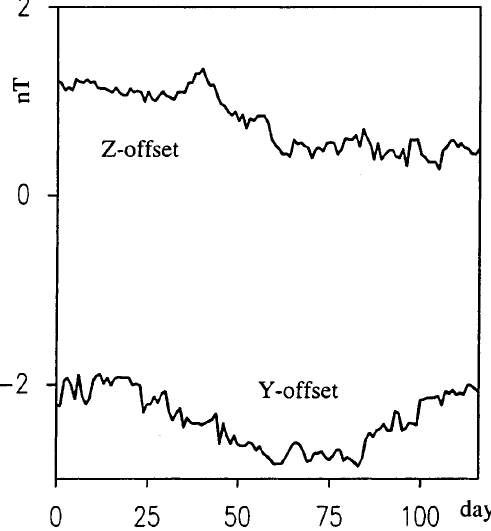
Fig. 4. O(cid:128)set behaviour of the components perpendicular to the spin axis over 120 days